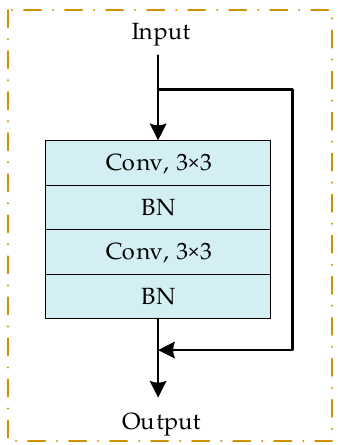
Figure 4. The identify block of ResNet used in this article.